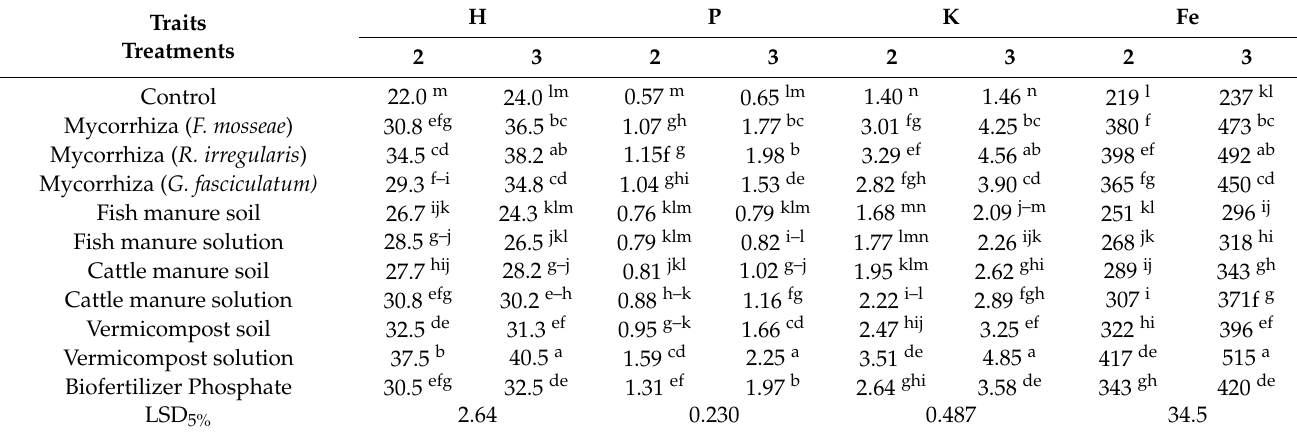
Table 7. Mean comparisons for interaction effects of year × treat for some savory